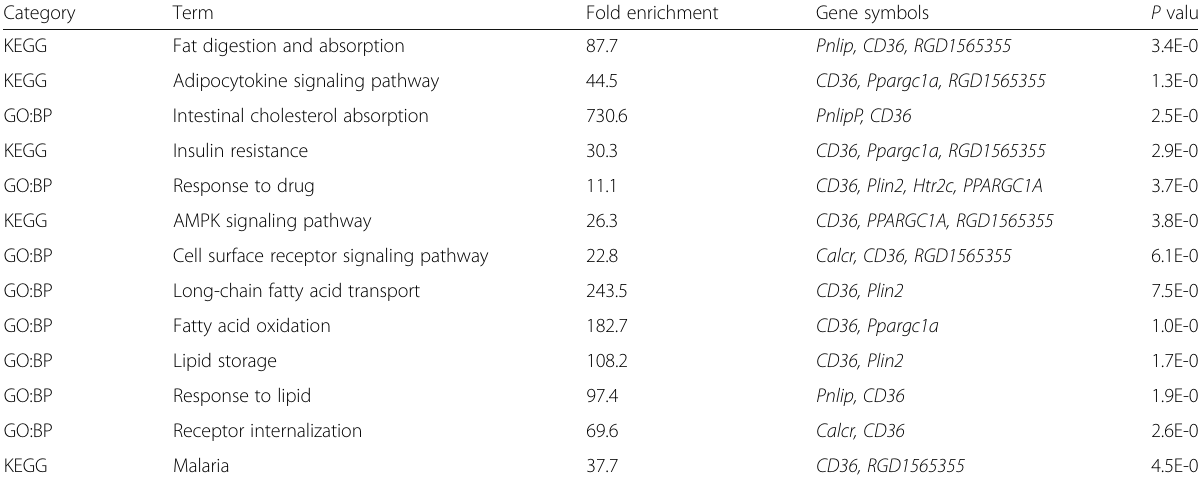
Table 2 Enriched KEGG pathways and GO:BP categories among the genes increased by EPO and inhibited by LIF at 20 h Category Term Fold enrichment Gene